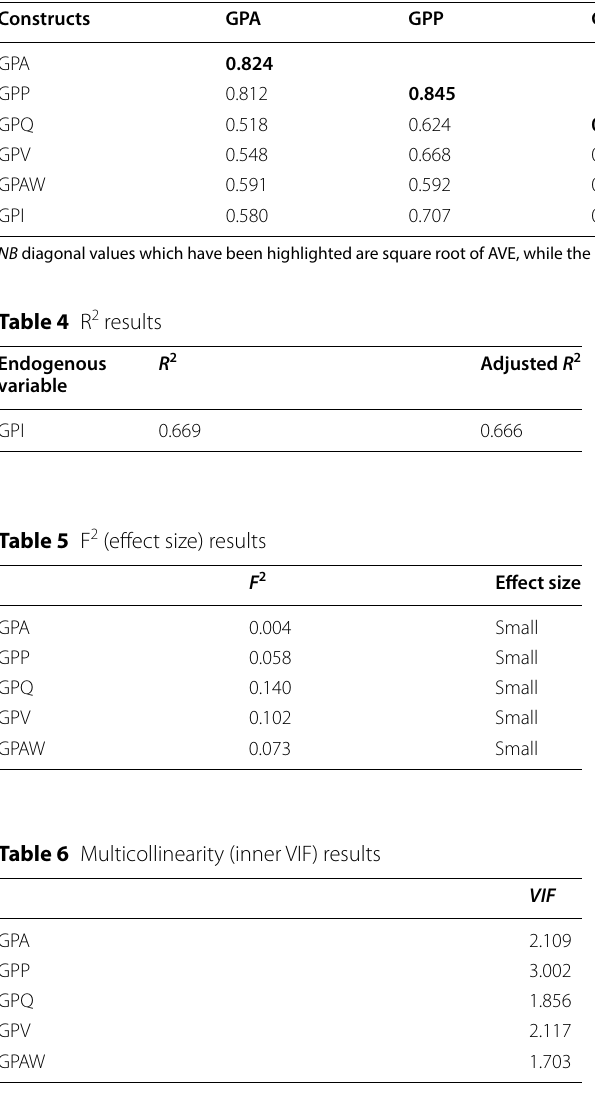
Table 3 Fornell–Larcker criterion